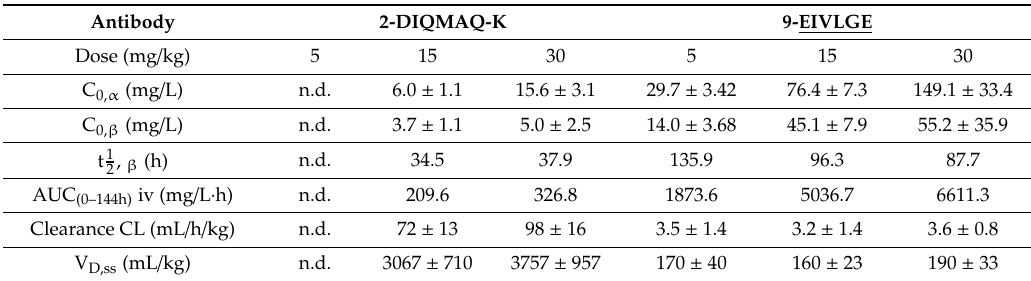
Figure 8. Pharmacokinetics of parental BaxM159 2-DIQMAQ-K ( A ) and BaxM159 variant 9-EIVLGE ( B ) after intravenous administration to MF1 nude mice. BaxM159 variants were injected intravenously via the tail vein into male MF1 nude mice ( n = 4) at doses of 5, 10, 30 mg/kg. Blood (80 µL) was drawn at the indicated time points and centrifuged to generate plasma. The concentration of human IgG was determined by ELISA in these plasma samples. The solid lines in panel ( A ) and ( B ) were drawn by fitting the data points to the equation for a biexponential decay/two-compartment model with the notable exception of the curve for 5 mg/kg parental BaxM159 2-DIQMAQ-K (squares in ( A )). It is evident that the concentrations of the 5 mg/kg parental BaxM159 2-DIQMAQ-K were below the detection limit at time points > 48 h. Hence, there were not enough data points and the data were only fitted to the equation for a monoexponential decay. The insets show the logarithmic transformation of the data to illustrate the presence of two components. Table 3. Pharmacokinetic parameters of antibody 9-EIVLGE and parental antibody 2-DIQMAQ-K derived from an in vivo study in male MF1 nude mice. The kinetic parameters initial concentration (C 0 ), clearance CL, exposure (AUC 0–144 = area under the curve from 0 to 144 h), terminal or beta phase half-life (t 1 , β ), and volume of distribution at steady state (V D,ss ), were calculated by fitting the data 2 summarized in Figure 8 to an equation for biexponential decay ( = two-compartment model), where the α -phase and the β -phase are assumed to reflect the distribution phase (i.e., the transfer from a central to a peripheral compartment) and the elimination, respectively. Note that for the dose of 5 mg / kg of parental 2-DIQMAQ-K the concentrations at time intervals > 48 h were below the detection limit; hence, kinetic estimates could not be determined (n.d.). CL and V D,ss were adjusted for mouse body weight (30 g). Data represent parameter estimates and their standard